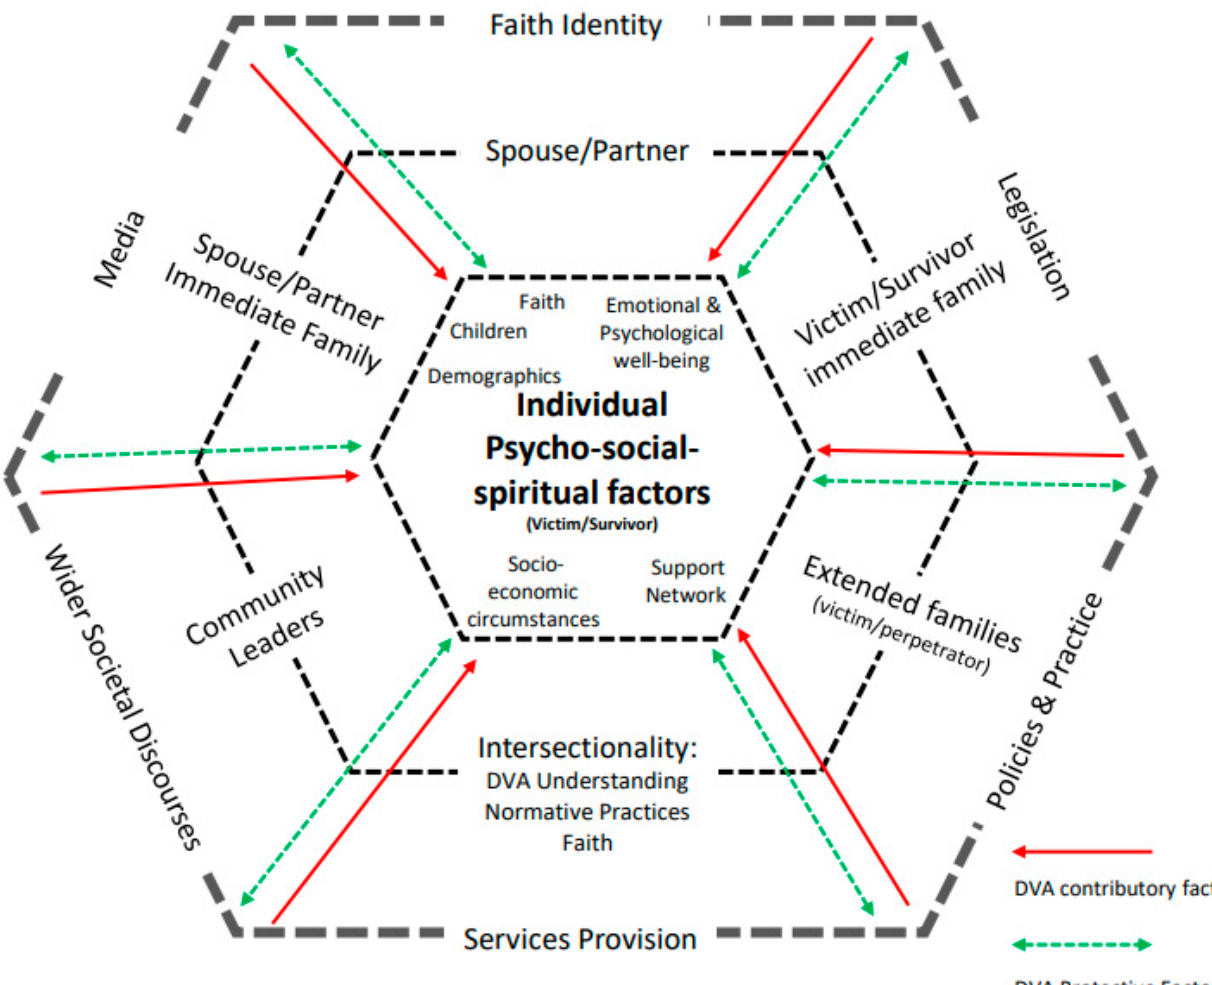
Figure 1. Web model of Domestic violence and abuse (Chowdhury